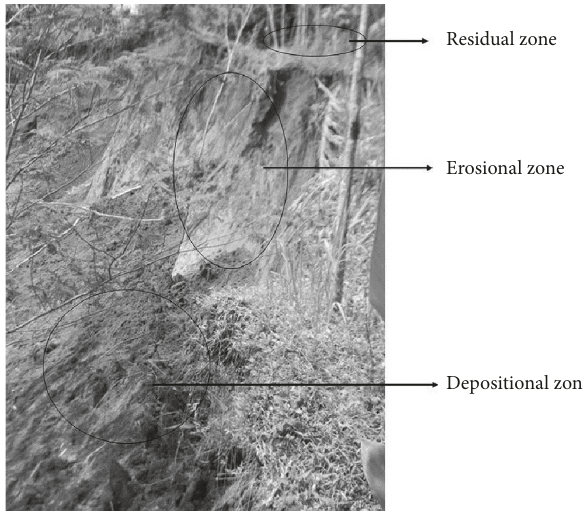
Figure 2: Zones in landslide prone area.